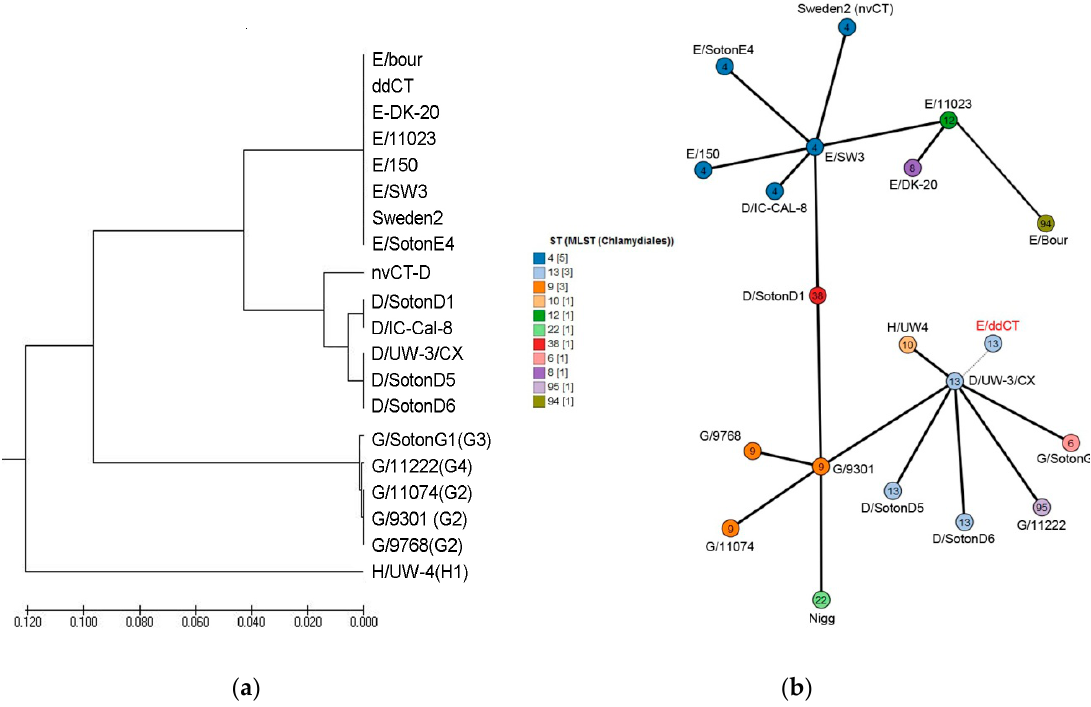
Figure 2. ( a ) Phylogenetic tree demonstrating the relationship of the ompA sequences of ddCT (GenBank accession No. MH782166), nvCT, nvCT-D (GenBank accession No. KY474386) to reference strains of C.t. genovar E from Table 2. Thick branches, subtending all large clades, represent 100% bootstrap support. The scale at the bottom represents one substitution per site. ( b ) GrapeTree clustering of 10 STs available in Chlamydiales PubMLST database (Available online: https: // pubmlst.org / chlamydiales / ). Each node corresponds to a single ST with an individual color (see on the left) represented by the relevant C.t. genovar(s) / clinical isolate (indicated around each node). Two C.t. deletion variants, ddCT and nvCT (Sweden2) belong to di ff erent clusters, ST13 and ST4, respectively.